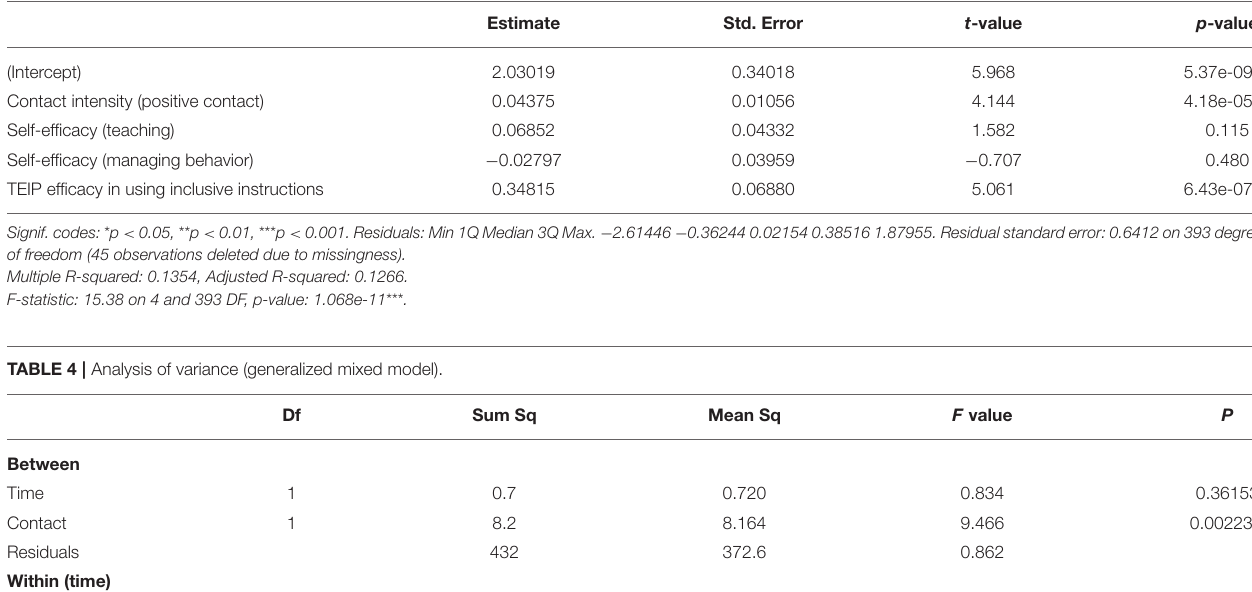
TABLE 3 | Coefficients: attitudes toward inclusion (EFIL).